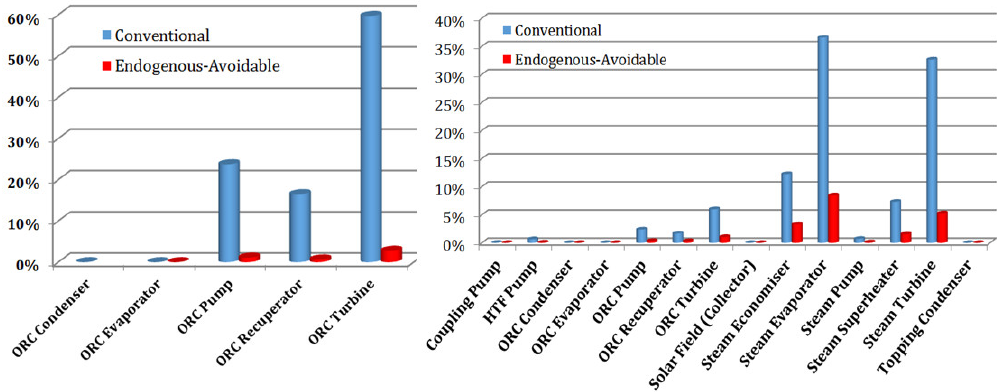
Figure 13. Comparisons of exergo-environmental analysis results including conventional and advanced (in the GPP and SGPP).